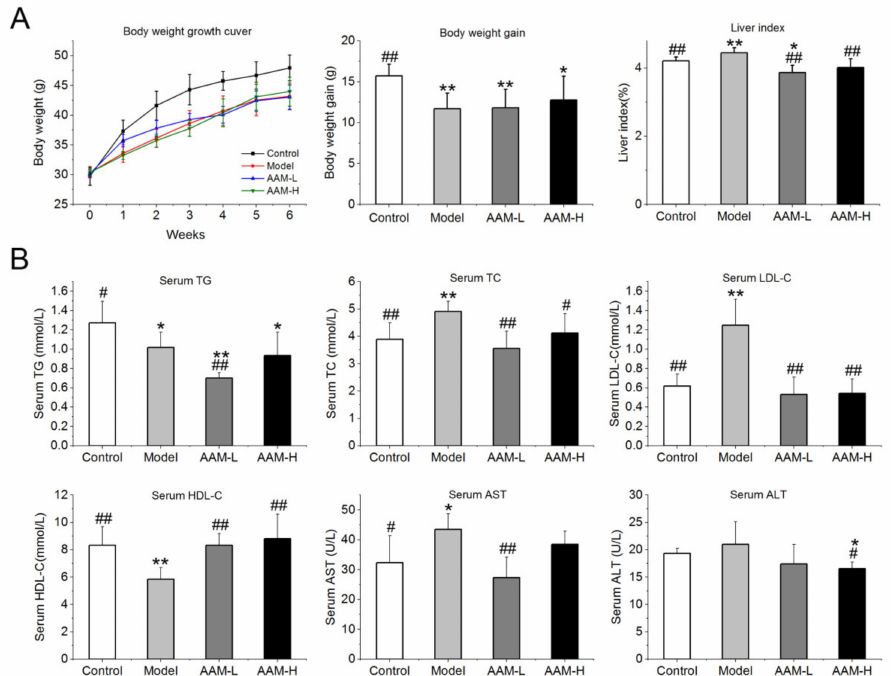
Figure 2. Effects of AAM administration on physiological parameters and the serum biochemical profile in mice exposed to alcohol intake for consecutive 6 weeks. ( A ) Bodyweight growth curve, body weight gain and liver index of mice; ( B ) Serum levels of TG, TC, LDL-C, HDL-C, AST and ALT. ## p < 0.01 and # p < 0.05, versus the Model group; ** p < 0.01 and * p < 0.05, versus the Control